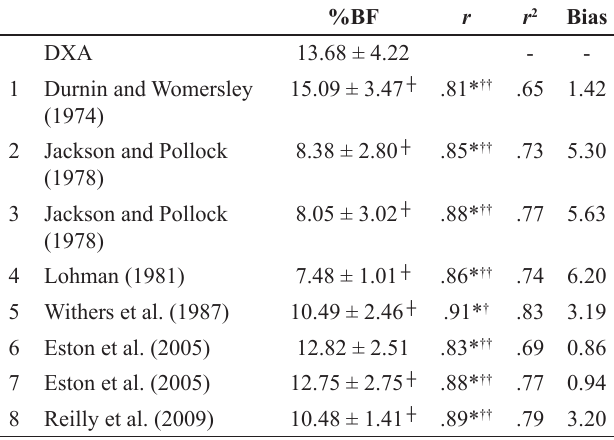
MA = midaxillary; AB = abdominal; AT = anterior thigh; Σ dominal plus midaxillary; r = multiple correlation coefficient; r 2 = determination coefficient; r a2 = adjusted determination coefficient; SE= adjusted coefficient; † Denotes nearly perfect